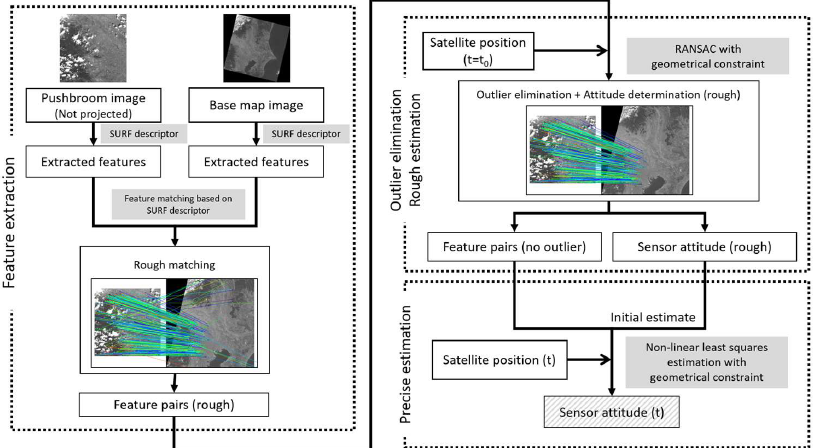
Figure 1. Overview of proposed method for satellite attitude determination based on pushbroom (not projected) and base-map images. The method consists of three major steps; feature extraction, outlier elimination and rough attitude estimation, and precise attitude estimation.